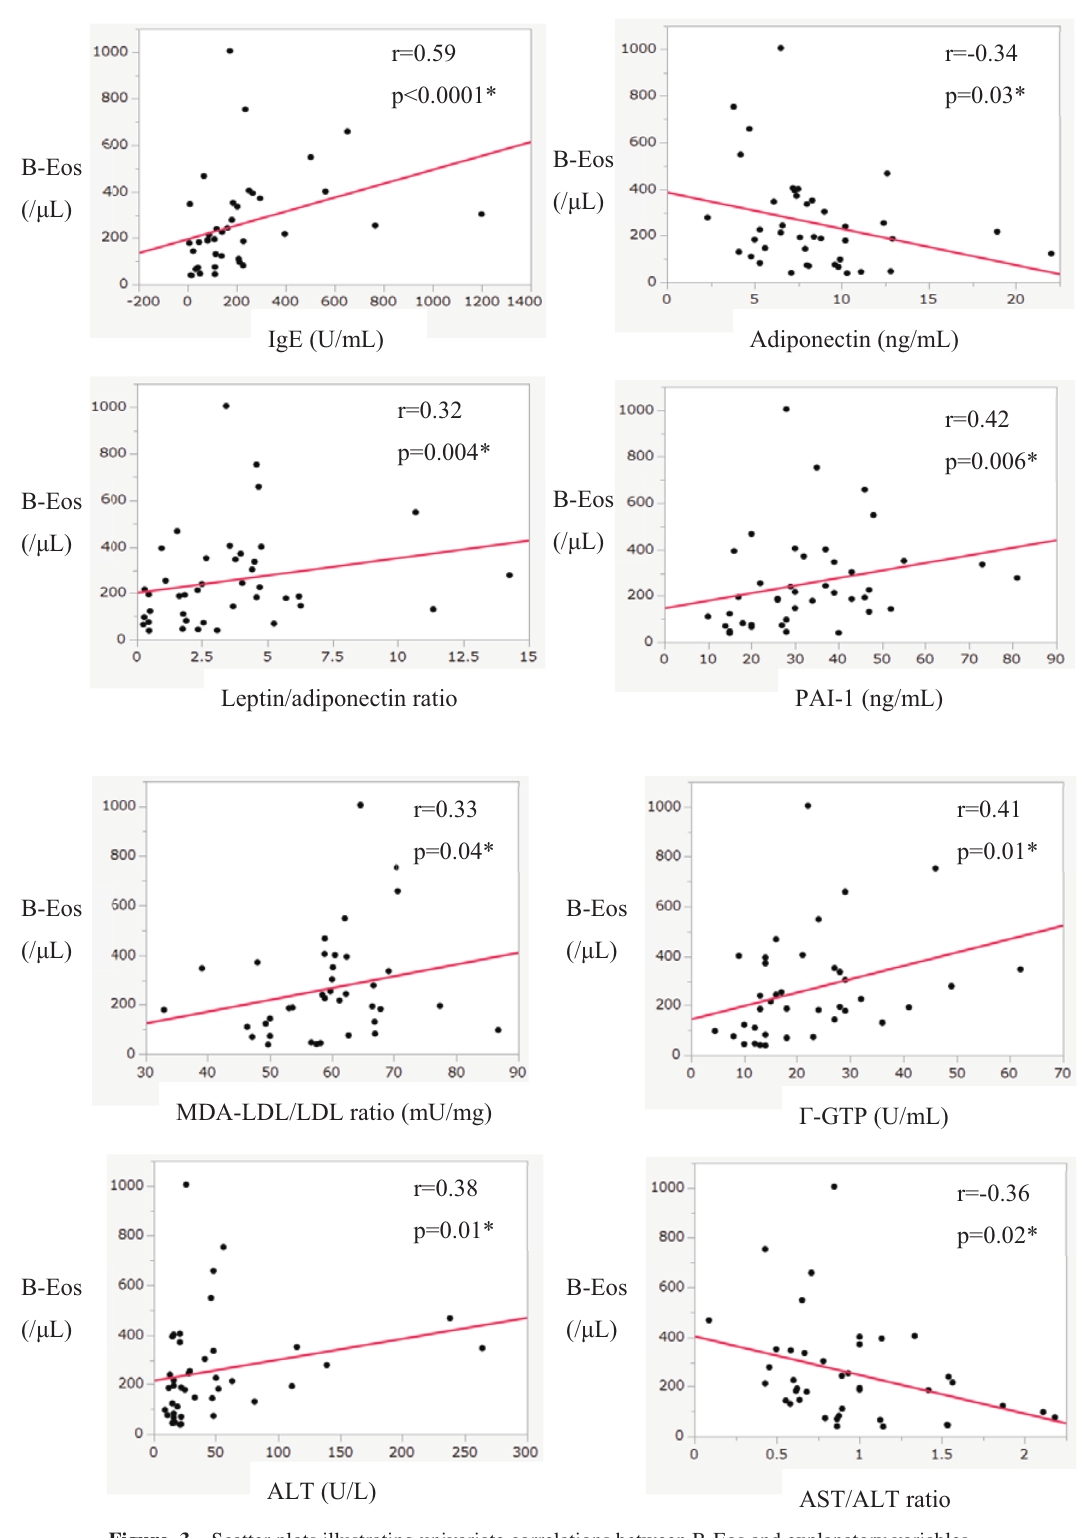
Fi g ure 3 Scatter plots ill u stratin g u ni v ariate correlations bet w een B-Eos and explanator y v ariables. B-Eos, blood eosinophil co u nts; I g E, imm u no g lob u lin E; P AI-1, plasmino g en acti v ator inhibitor-1; MDA-LDL, malondialdeh y de-modified lo w -densit y lipoprotein; LDL, lo w -densit y lipoprotein;